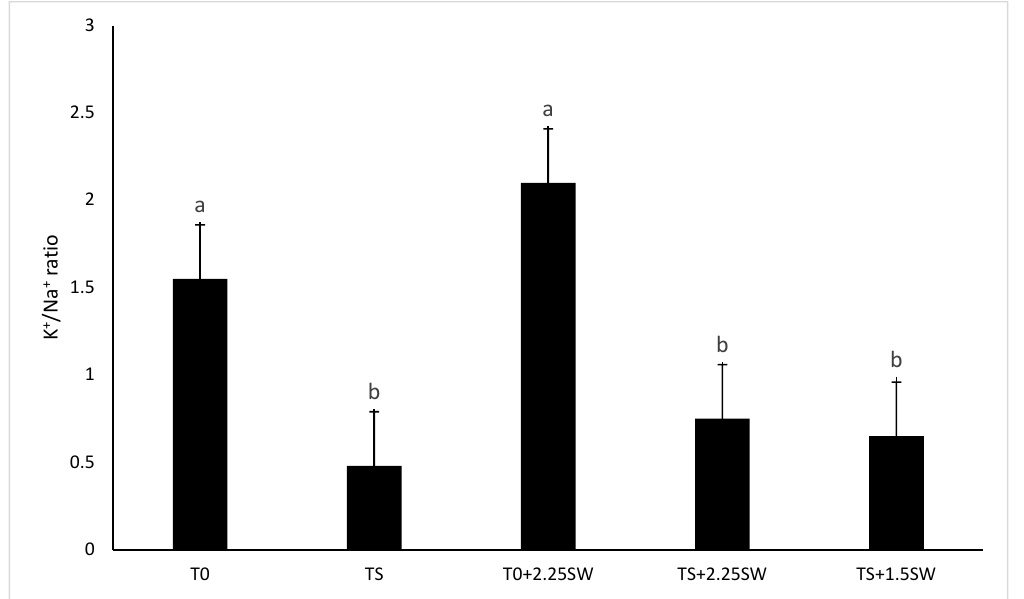
Figure 4. The K + /Na + ratio in the leaves on 2 year Hass avocado plant grown in pot for 240 days with different treatments (T0: distilled water, TS: saline water (9 mM NaCl), T0 + 2.25SW: distilled water + 2.25 mL seaweed, TS + 2.25SW: saline water (9 mM NaCl) + 2.25 mL seaweed T0 + 1.5 mL seaweed) with 6 replicates per treatment. Means with different letters indicate significant differences between treatments (Tukey test p <